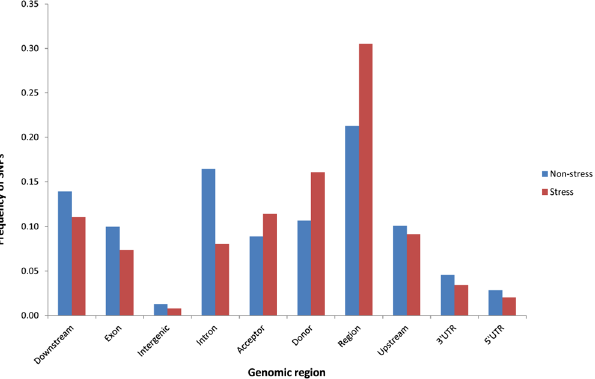
Figure 2. Frequency of SNPs mapped in genomic regions in waterlogging tolerant genotype (HKI 1105) of maize. SNPs were mapped differentially in various genomic regions of non-stress and stress samples. X-axis represents the genomic regions in which SNPs were mapped and y-axis represents SNP